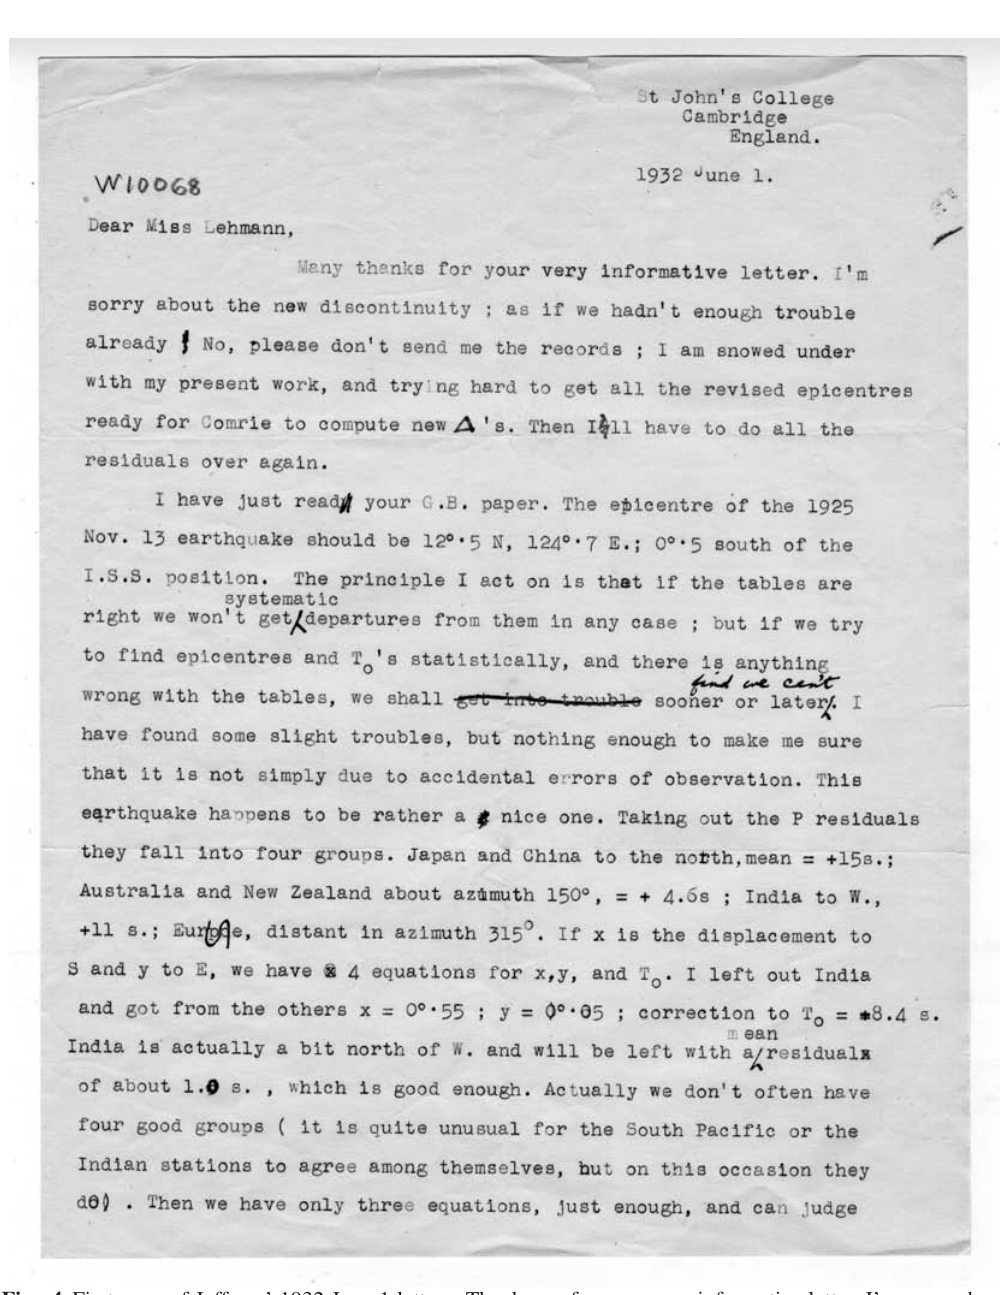
Fig. 4. First page of Jeffreys’ 1932 June 1 letter. «Thank you for your very informative letter. I’m sorry about the new discontinuity». « No please don’t send me the records; I am snowed under with my present work». It appears that Jeffreys is not interested in the new discontinuity in the